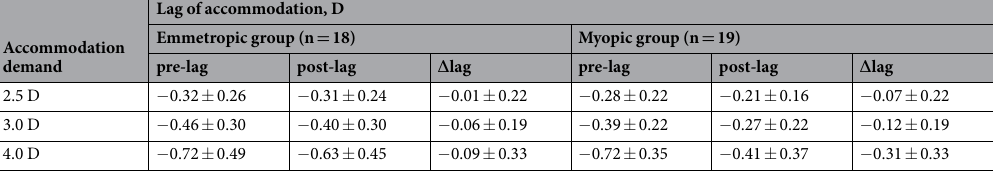
Table 1. Accommodation training results in habitual lens wear. Accommodative lag (mean ± SD) at baseline (pre-lag), after the training (post-lag), and training effects ( Δ lag = pre-lag − post-lag) in emmetropic and myopic subjects while wearing habitual contact lenses. Negative values for Δ lag indicate an improvement of accommodation accuracy after training.